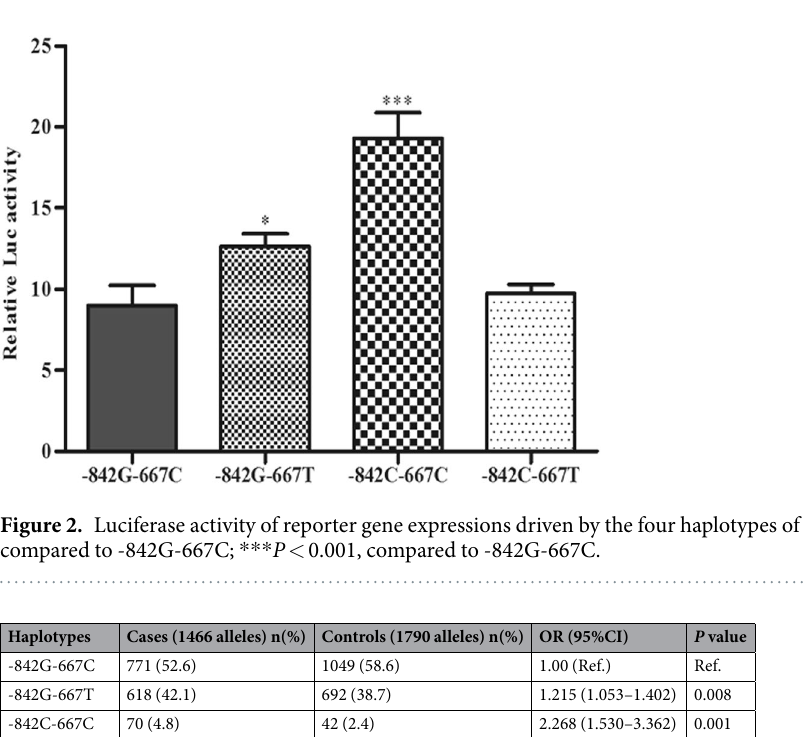
Table 3. PIN1 -842G > C and -667C > T haplotypes and nasopharyngeal carcinoma risk. a Global test.